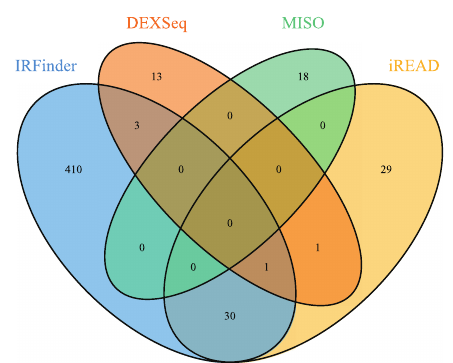
Fig. 6 Venn diagram showing the intersection of GO terms enriched in the retained introns obtained by IRFinder, DEXSeq, iREAD, and MISO. The only GO term shared by IRFinder, DEXSeq, and iREAD is the astrocyte development (GO: 0014002), whose annotated genes include the known AD-associated gene APP. The only GO term shared by iREAD and DEXSeq is the neuron projection organization (GO: 0106027), whose annotated gene includes the AD risk gene